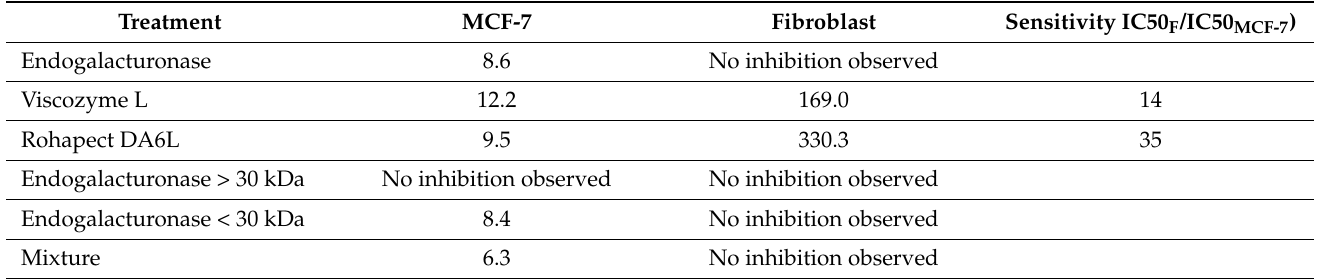
Table 4. Comparison of IC50 (mg/mL) for the proliferation inhibition of MCF-7 and fibroblasts by the tested